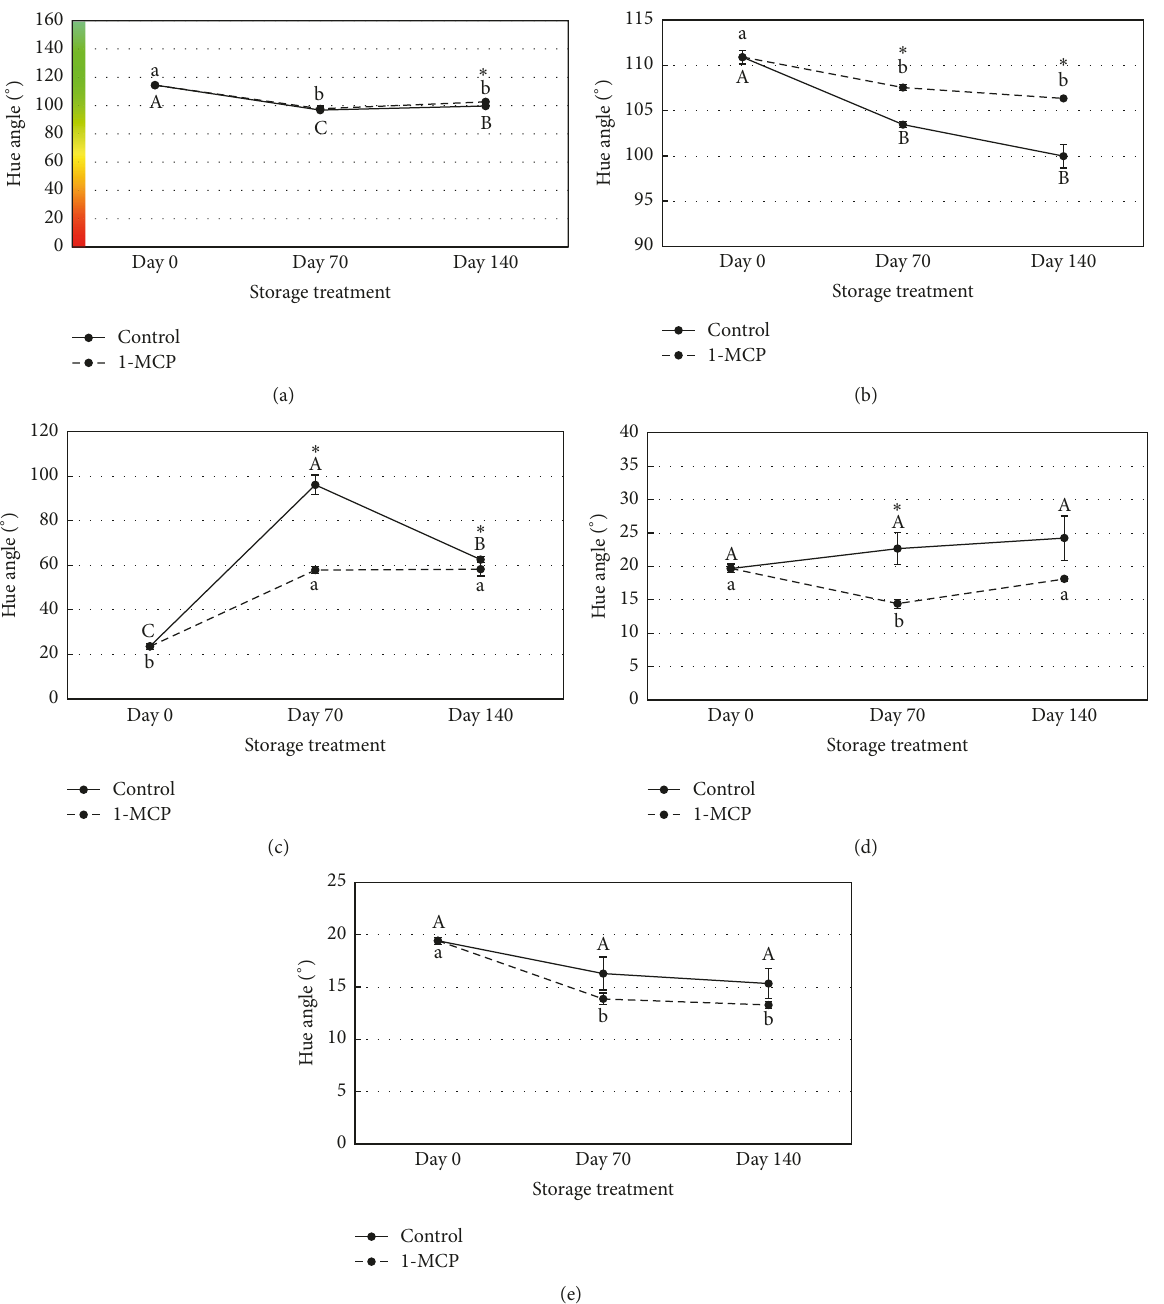
Figure 3: Hue angle ( ∘ ) of apple fruit at (a) “Golden Delicious,” (b) “GoldRush,” (c) “WineCrisp,” (d) “Pixie Crunch,” and (e) “CrimsonCrisp” apples at harvest and 70 or 140 days of storage at 0 ∘ C followed by 7 days at 20 ∘ C. Day 0, at harvest; Day 70, 70 days of storage at 0 ∘ C followed by 7 days at 20 ∘ C; Day 140, 140 days of storage at 0 ∘ C followed by 7 days at 20 ∘ C. Capital letters and lowercased letters indicate mean separation among storage duration treatment of control and 1-MCP-treated apples, respectively, by Tukey’s HSD at 𝑝 < 0.05 . Asterisks ( ∗ ) indicate significant difference between control and 1-MCP treatment in each cultivar at each storage duration using Student’s 𝑡 -test at 𝑝 < 0.05 . Vertical bars represent standard error ( 𝑛 = 4